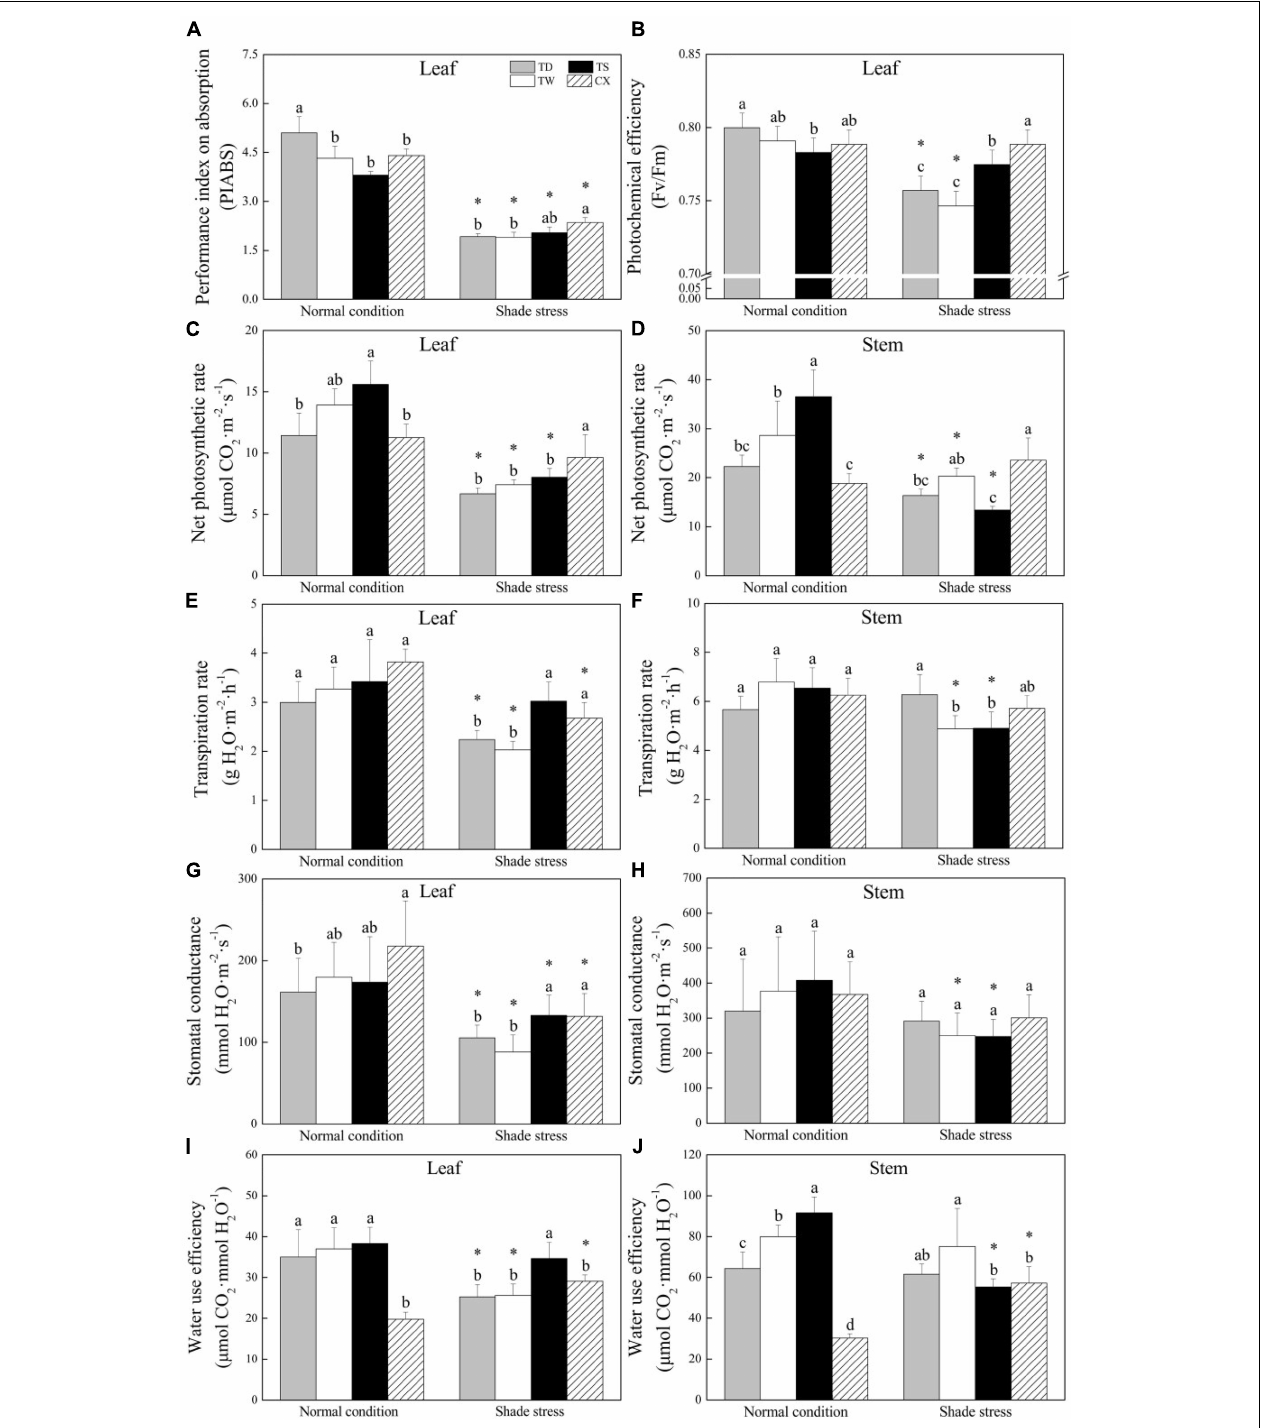
FIGURE 4 | Effects of shade stress on (A) performance index on absorption in leaf, (B) photochemical efficiency of PS II in leaf, (C) net photosynthetic rate in leaf, (D) net photosynthetic rate in stem, (E) transpiration rate in leaf, (F) transpiration rate in stem, (G) stomatal conductance in leaf, (H) stomatal conductance in stem, and (I) water use efficiency in leaf, and (J) water use efficiency in stem of four bermudagrass cultivars. Vertical bars indicate the ± SE of mean ( n = 4). Different letters above columns indicate significant differences ( p ≤ 0.05) among four cultivars under normal conditions or shade stress. The asterisk ( ∗ ) above letter indicates a significant difference ( p ≤ 0.05) in one particular cultivar between normal conditions and shade stress.